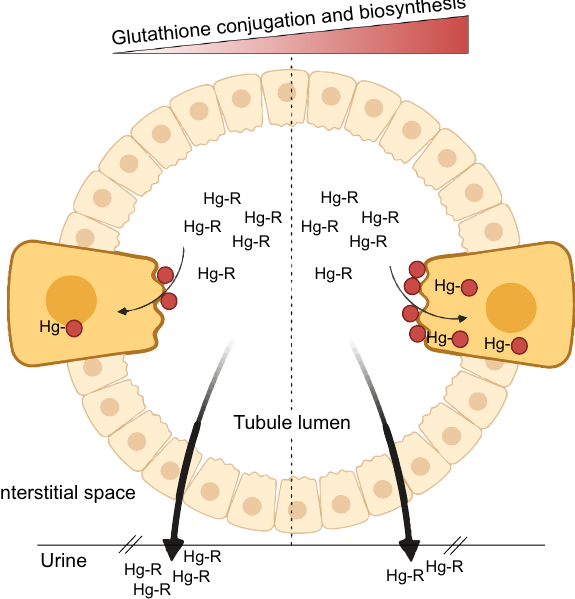
Figure 3. Graphical representation of contributing biosynthesis and conjugation of glutathione underlying Hg-kidney toxicity. The graph shows a cross-section of the proximal tubule of neprhon, where two cells were magnified to represent the reabsorption of glutathione-Hg conjugates. Hg contained in the primary urine after glomerular filtration is presented as Hg-R, where R is any molecule attached to it (e.g., albumin). The dotted line split the graph in two sections according to the level of biosynthesis and conjugation of glutathione (red circles): lower levels on the left and high levels on the right. At the level of the luminal plasma membrane of proximal tubular epithelial cells, glutathione-Hg conjugates are internalized by a mechanism of molecular homology such as dicysteinylmercury (cysteine-Hg-cysteine). Thus, decreasing both biosynthesis (as in GCLM rs41303970-T carriers) and/or conjugation (as in GSTP1 rs4147581-C carriers) of glutathione could increase the Hg elimination in the urine due to a lower rate in the uptake of glutathione-Hg conjugates, mitigating kidney injury by this heavy metal. Created with BioRender.com and edited with Adobe